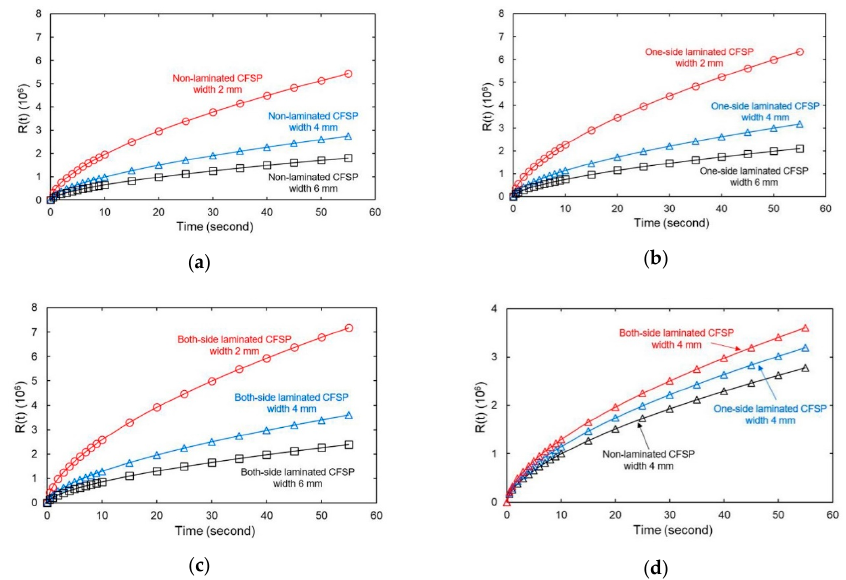
Figure 9. The fluidic resistance over time: ( a ) Non-laminated CFSP with various widths of paper strips ( b ) for one-side laminated CFSP; ( c ) Two-side laminated CFSP; ( d ) Various laminated conditions under the same width 4 mm of paper strips.